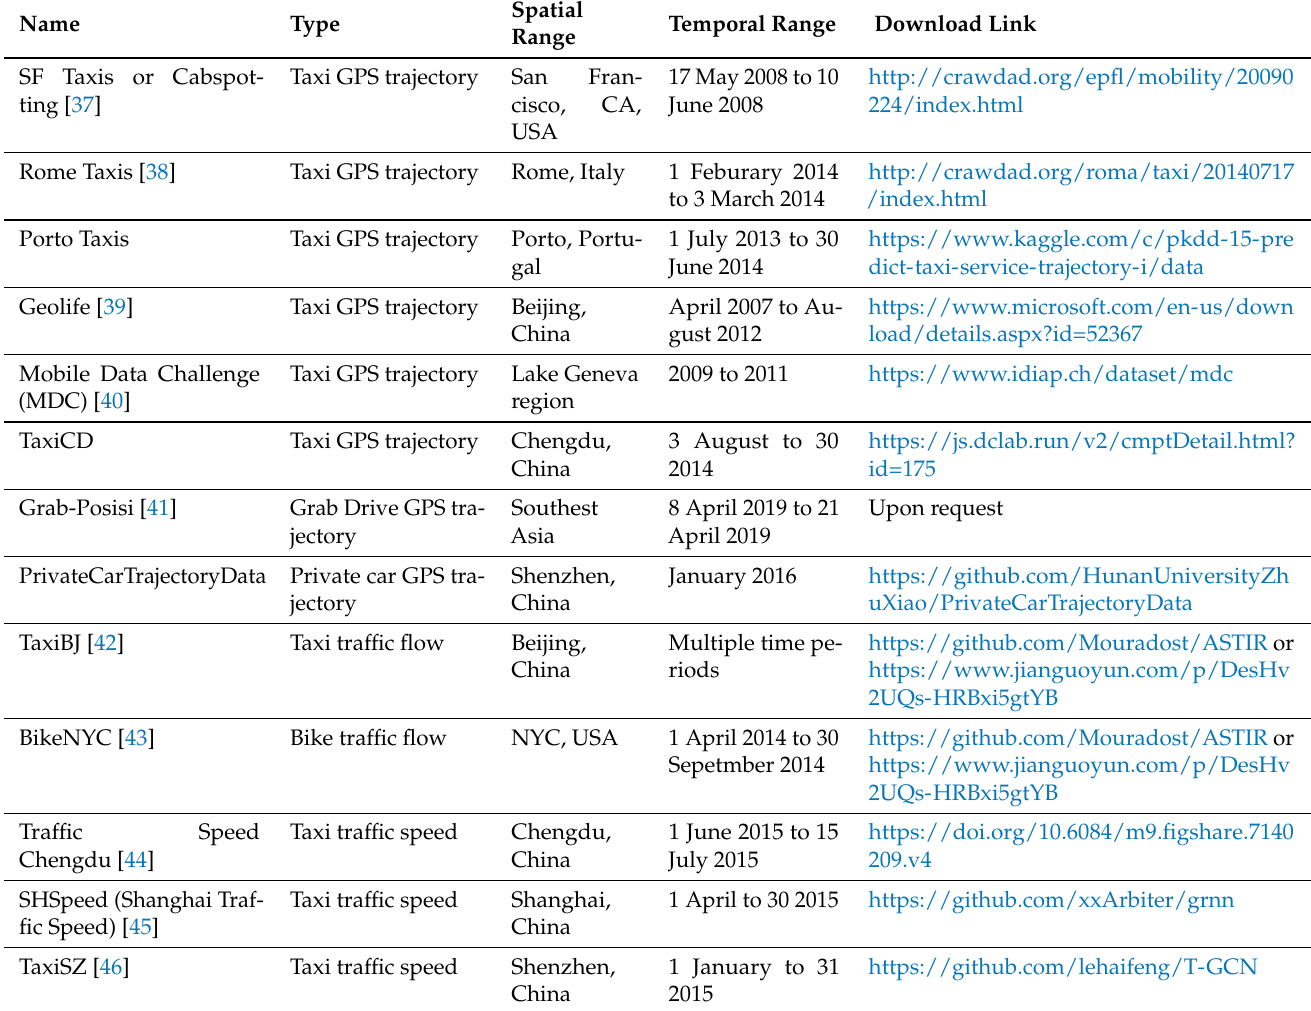
Table 4. The list of open GPS trajectory and relevant